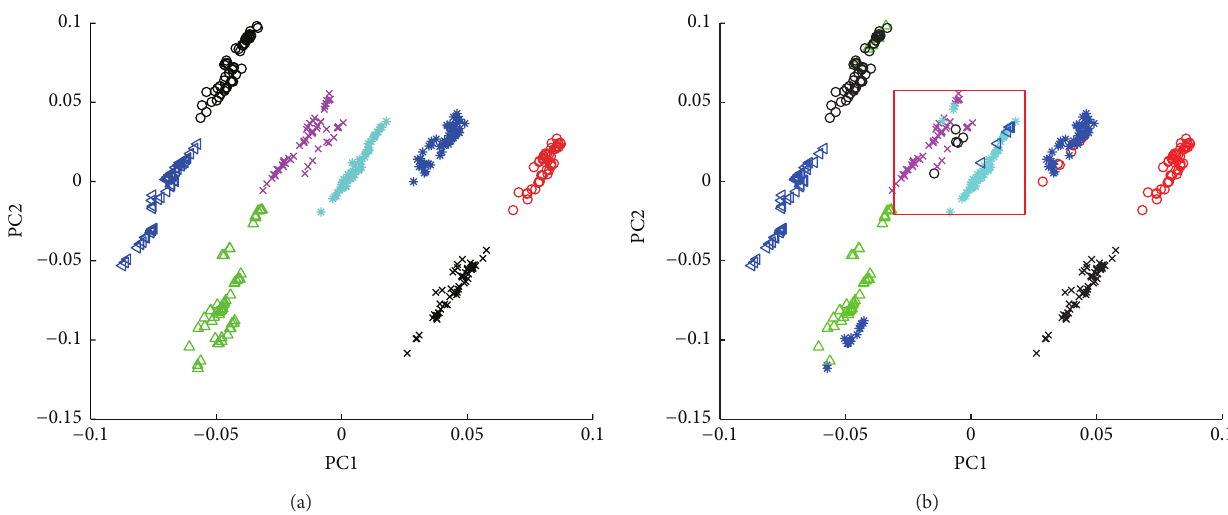
Figure 4: Score plots of the raw spectra by PCA of 8 different kinds of Hibiscus mutabilis L. samples in training sets and in prediction sets.